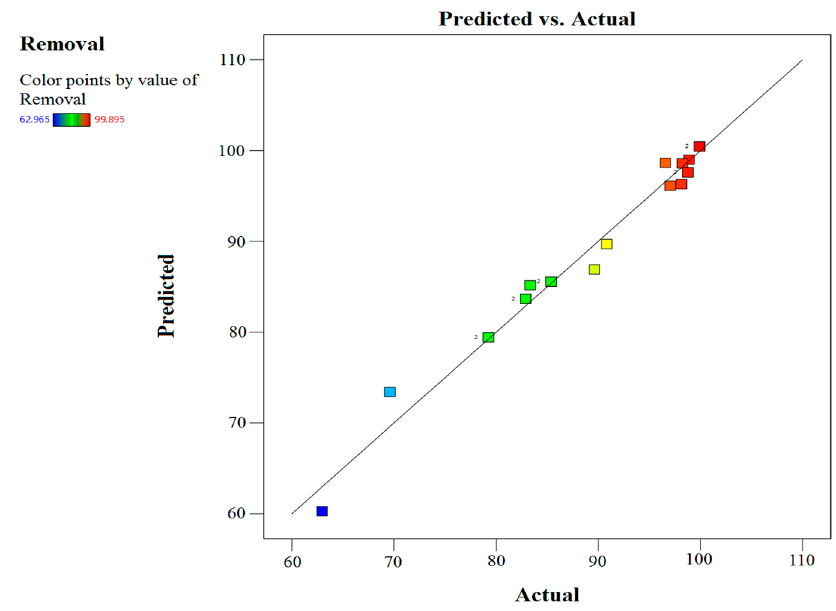
Figure 14. Plots between the predicted and experimental data for AO7 dye